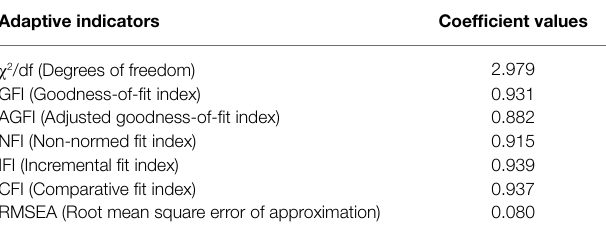
TABLE 1 | Adaptive indicators of entrepreneurial self-efficacy questionnaire.